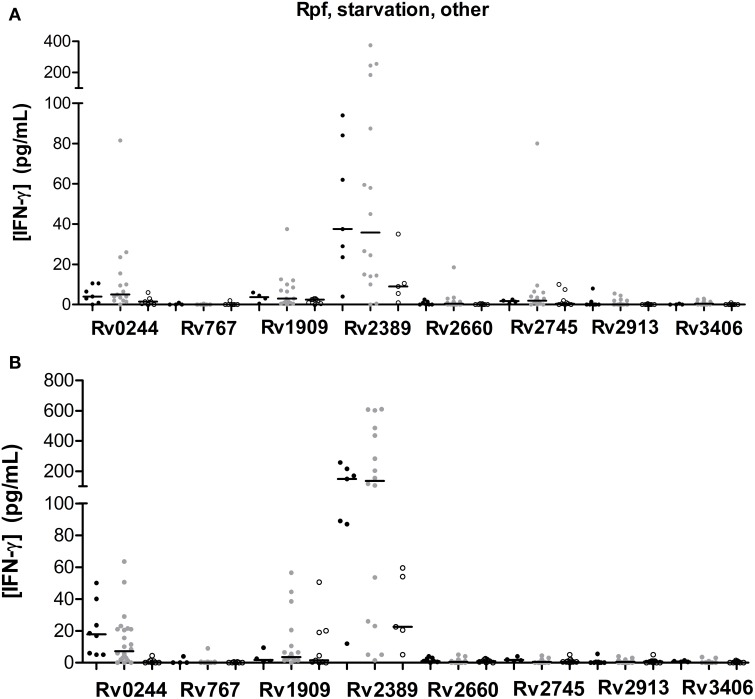
Rpf, starvation and other stress response-associated antigen stimulated IFN-γ response (pg/ml) after short (A) or long-term (B) incubation of whole blood from individuals without LTBI (black dots), with LTBI (gray dots), and active TB patients (empty dots). The horizontal line represents the median.